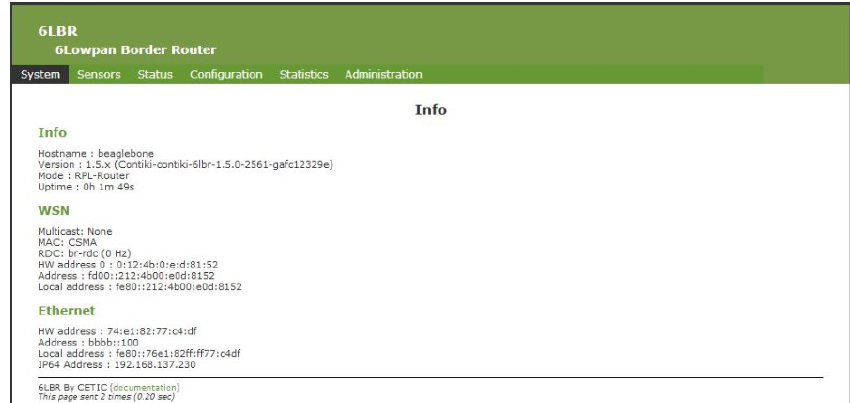
Figure A5. BeagleBone Black: Home